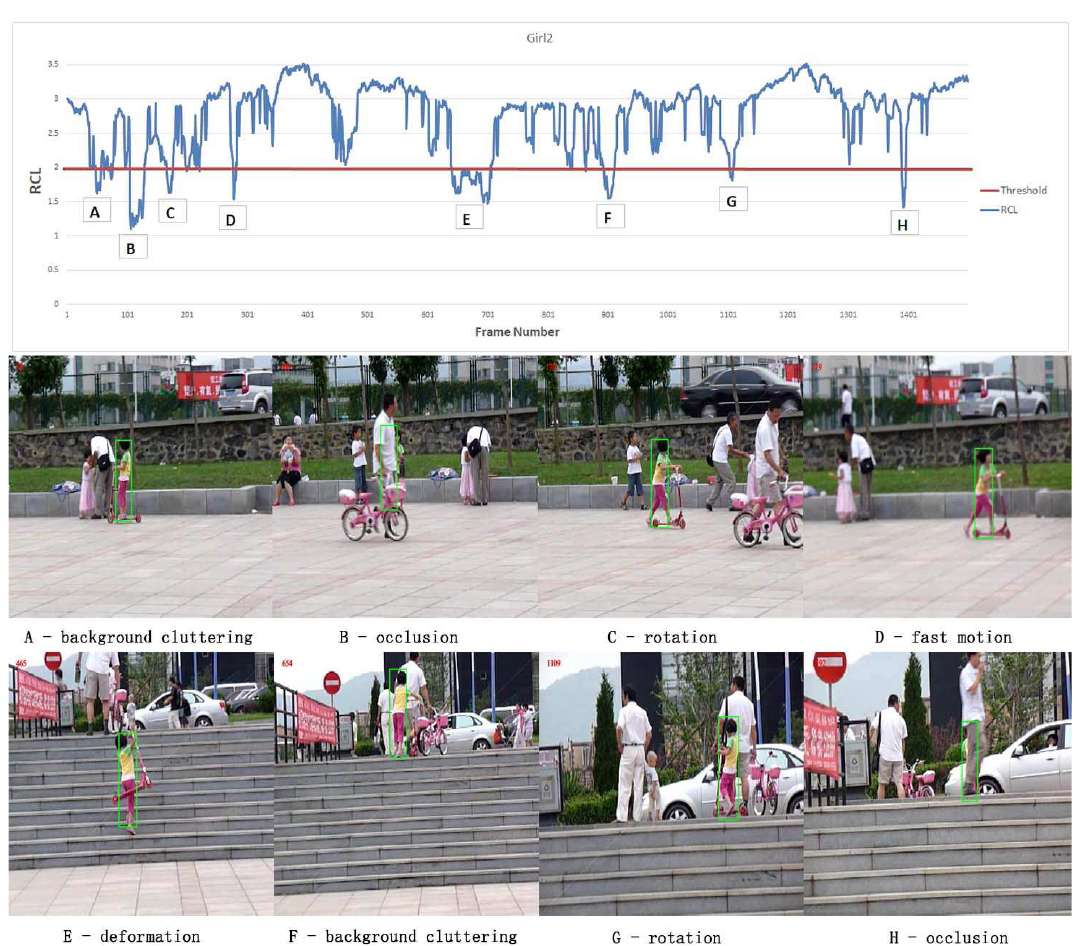
Figure 4. The correspondence between difficult tracking conditions and our proposed RCL criterion on test sequences girl